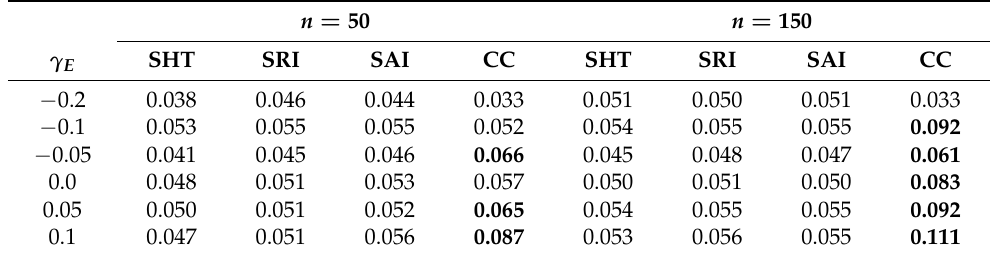
Table 3. Sensitivity analysis of the proposed test statistics in the second simulation